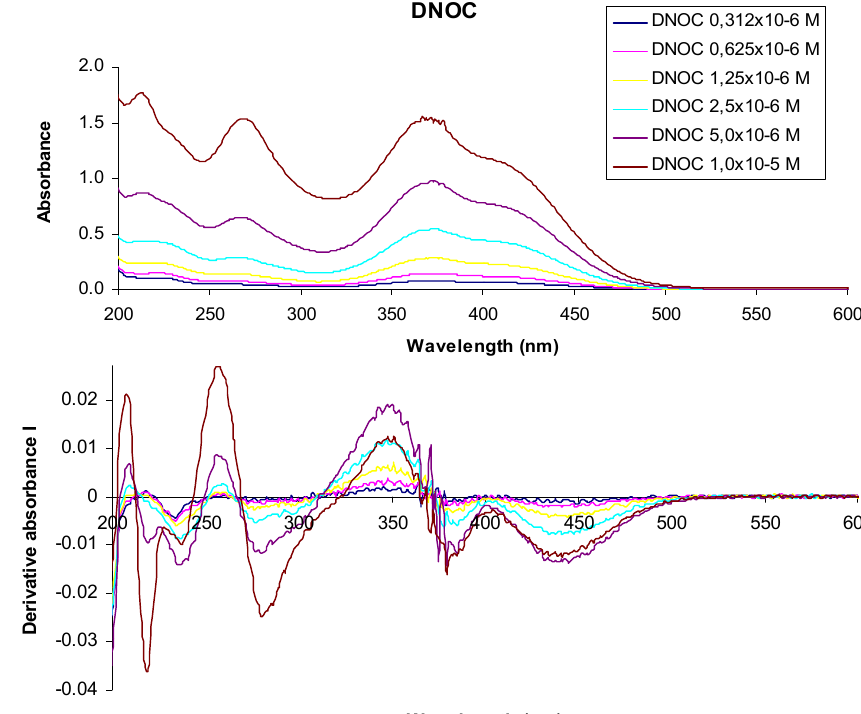
Figure 4. UV-VIS absorption spectra of 3,5-dinitro- o -cresol and their derivatives at various concentrations.